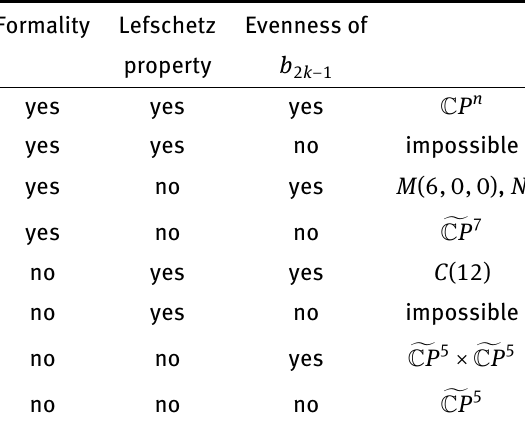
Table 2: Simply connected symplectic manifolds